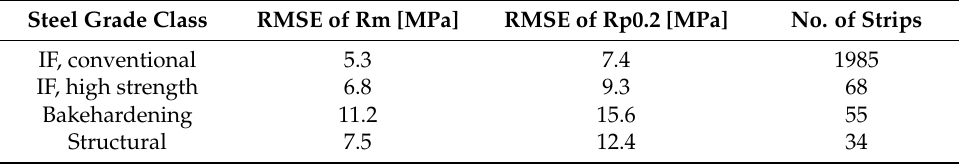
Table 7. Steel grade classes and results of verification measurements for Rm and Rp0.2.